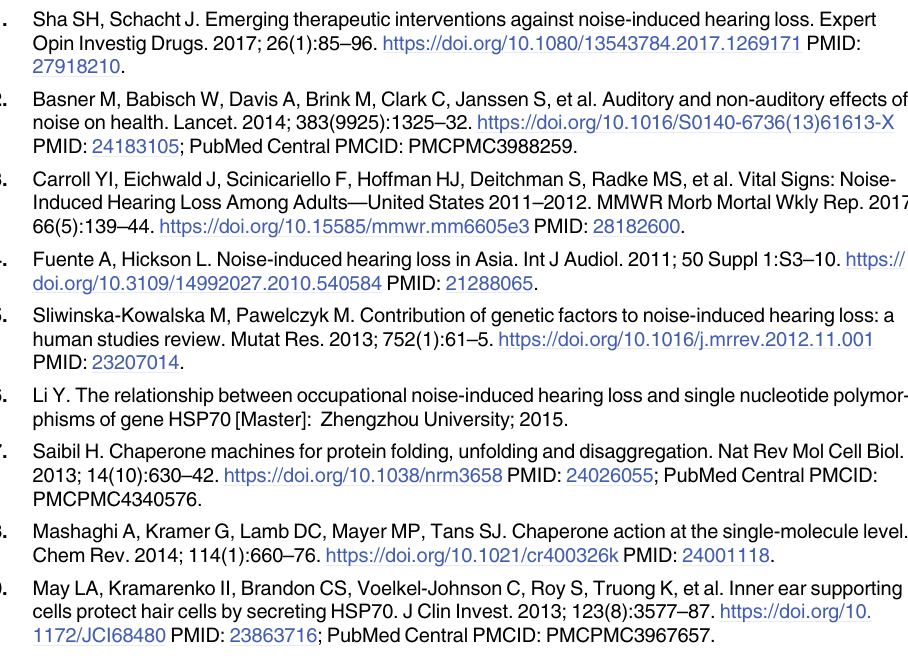
(ZIP) S1 Table. Excluded studies and reasons for exclusion.